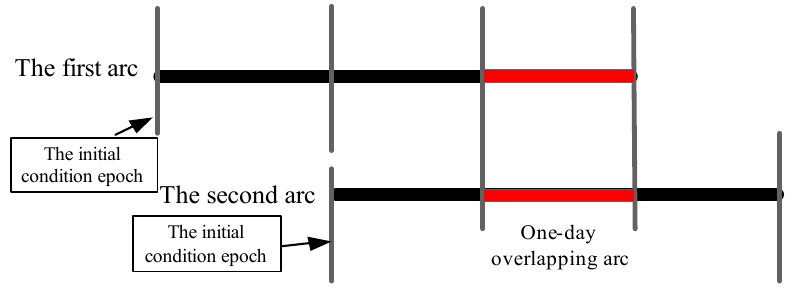
Figure 8. Sketch of the orbit overlapping arcs.